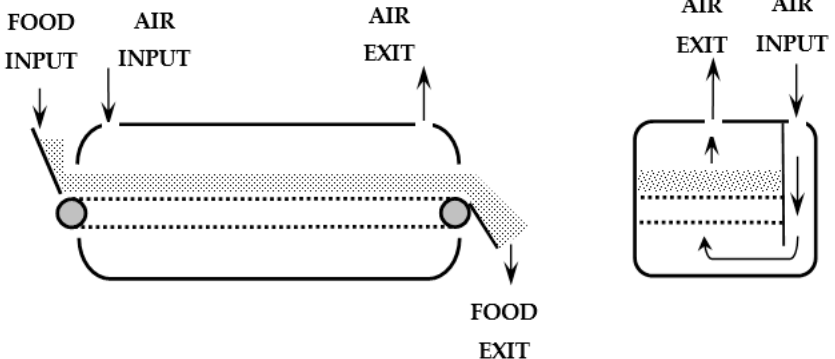
Figure 1. Through-circulation conveyor-belt dryer (perforated belt) in co-current: ( left ) side view; ( right ) front view.